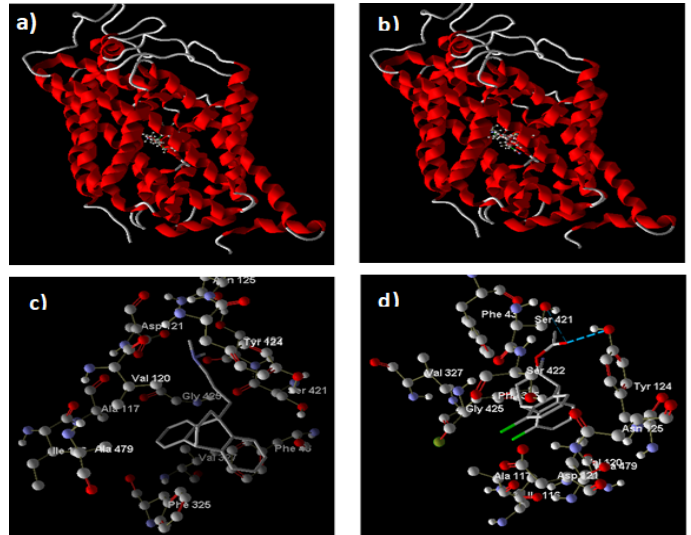
Figure 1. Structure of the 4xnx model complex with: ( a ) its ligand, ( b ) 6 anti and reference drug maprotiline, ( c ) pose of reference drug maprotiline 9 , ( d ) pose of compound 6 anti.